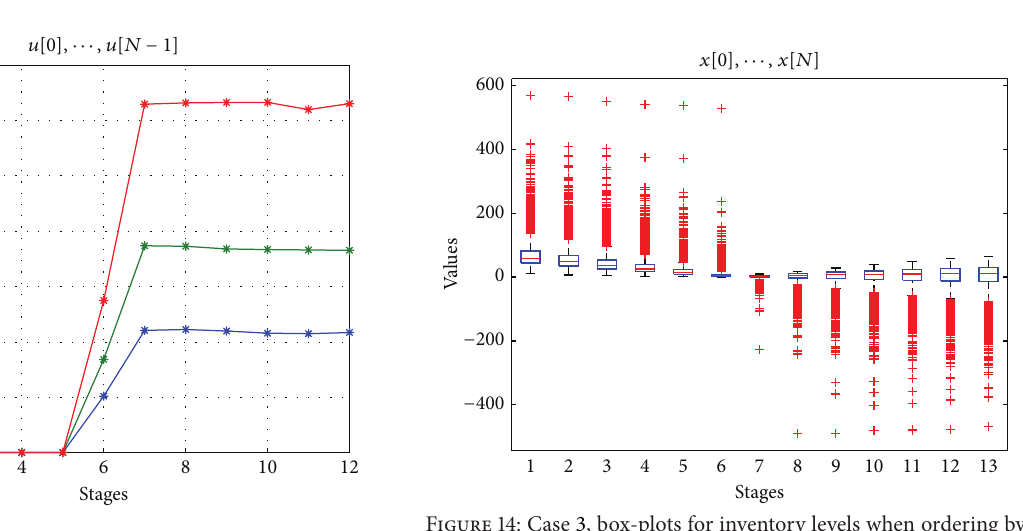
Figure 13: Case 3, box-plots for inventory levels when ordering by the median.